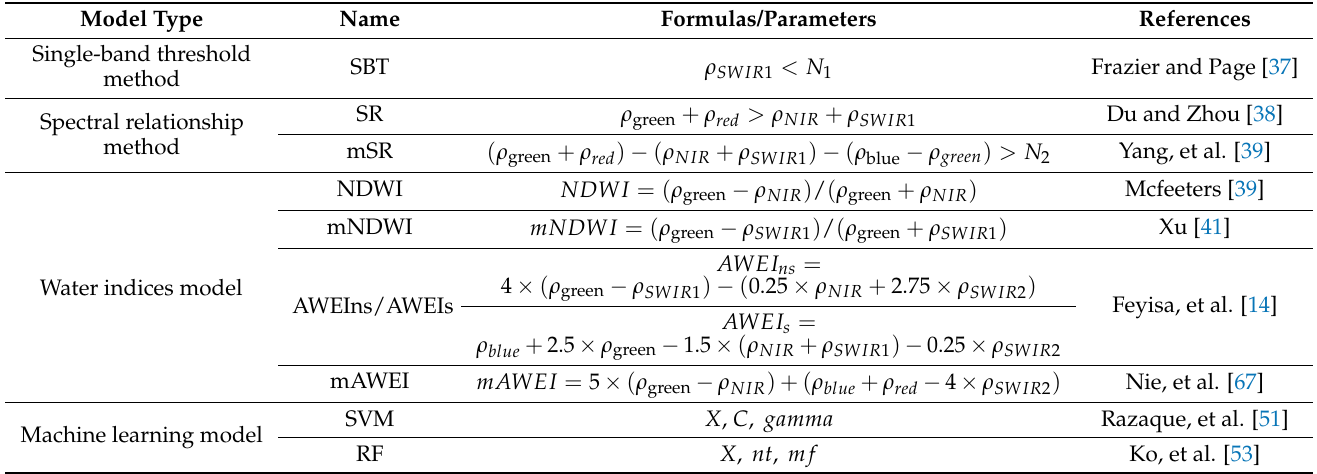
Table 2. Details of waterbody extraction